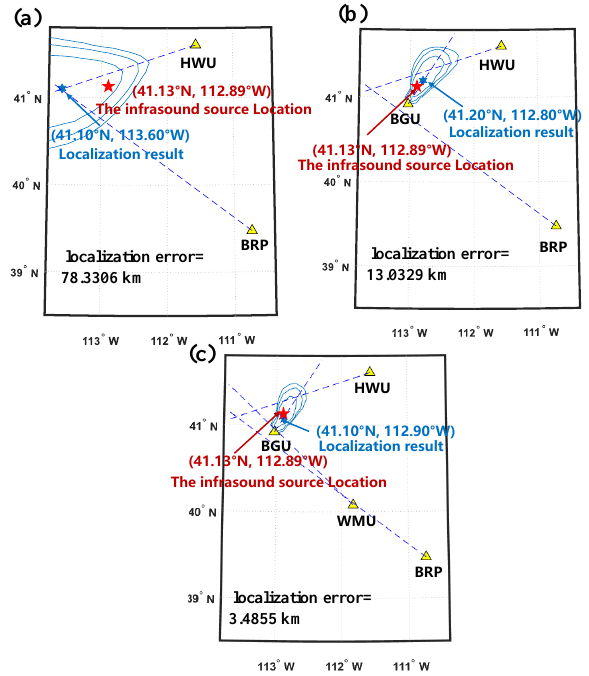
Figure 15. Localization errors for different numbers of stations (arrival azimuth estimation results from the SBL algorithm); ( a ) 78.3306 km for two stations (HWU and BRP); ( b ) 13.0329 km for three stations (BGU, HWU, and BRP); and ( c ) 3.4855 km for four stations (BGU, HWU, BRP, and WMU).